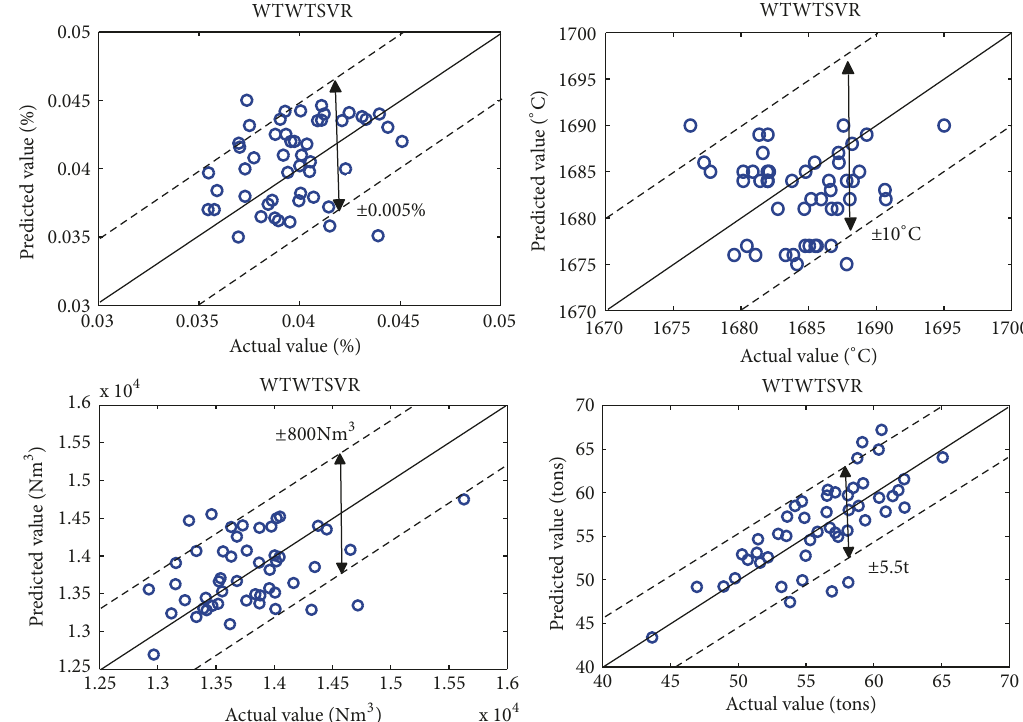
Figure 5: Performance of errors between predicted values and actual values with proposed static control model.